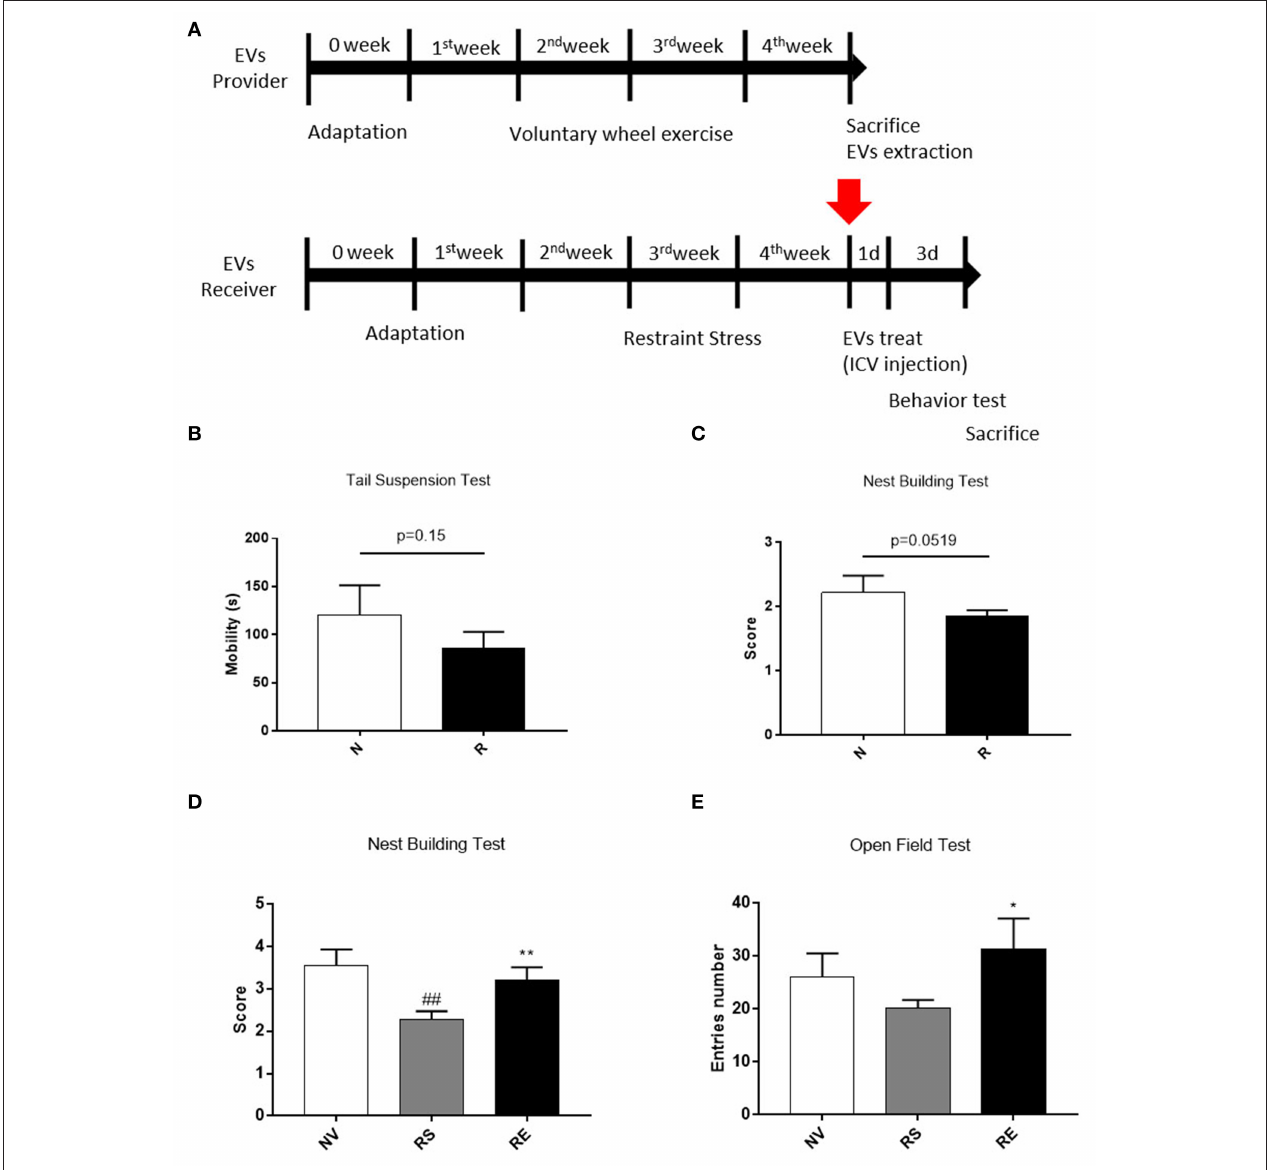
FIGURE 5 | The effects of 4 weeks of voluntary running wheel exercise-induced EVs on anxiety. (A) The experimental design (red arrows indicate EV ICV injection). (B) The mobility durations of the non-restrained and restrained groups on the tail-suspension test. (C) The group scores on the nest- building test prior to ICV injection. (D) The group scores on the nest-building test after ICV injection. (E) The center entry numbers in the open field test after ICV injection. All mice were male. N , non-restrained (6-week-old, n = 5); R , restrained (thus stressed) (6-week-old, n = 15); NV, non-restrained vehicle-injected group (11-week-old, n = 5); RS, restraint-stressed sedentary EV-injected group (11-week-old, n = 5); RE, restraint-stressed exercise EV-injected group (11-week-old, n = 5). * p < 0.05, ** p < 0.001 compared to the NV group, ## p < 0.001 compared to the RS group. Statistical analysis was performed using the one-tailed Student t